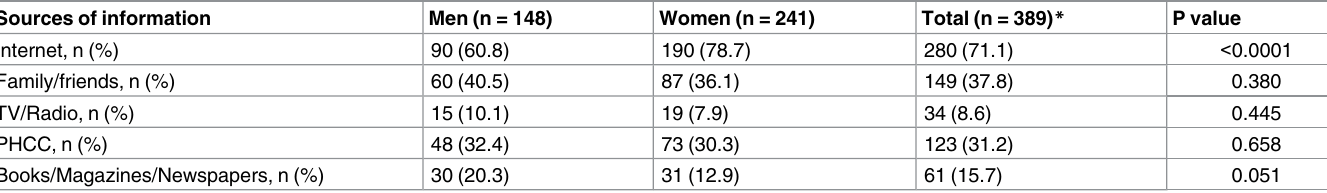
Table 2. Sources of health information used by Qatari Adults, according to gender.